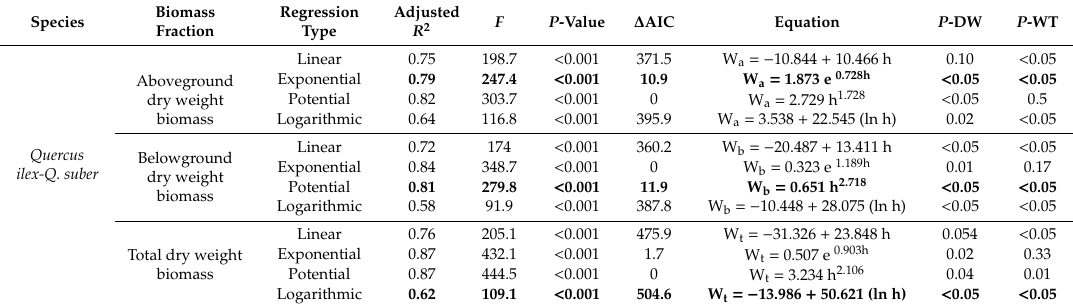
− 1 tree crown, to 24.94 Mg ha , in the inter-plantation area (Table 5). In the holm-cork oak plantation, − 1 the on-site C stock (W t -S + SOC 40 -S) reached 35.11 Mg ha , which translates into a landscape-wide − 1 − 1 mean annual rate of C sequestration of 0.47 Mg ha yr for the plantation (Table 5). Table 2. Allometric equations used for tree biomass estimation (W a = aboveground dry weight biomass, kg; W b = belowground dry weight biomass, kg; W t = total dry weight biomass, kg) for the Quercus ilex-Q. suber forest plantation in Andalusia (Southern Spain). Independent variables (h = total height, Durbin–Watson test for residuals autocorrelation (DW) and White test for homocedasticity (WT). The equations selected are in bold.